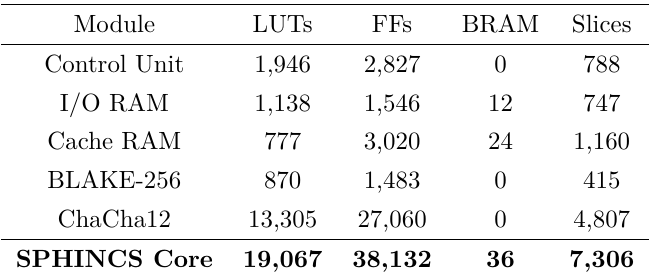
Table 3: Area utilization of the SPHINCS core.